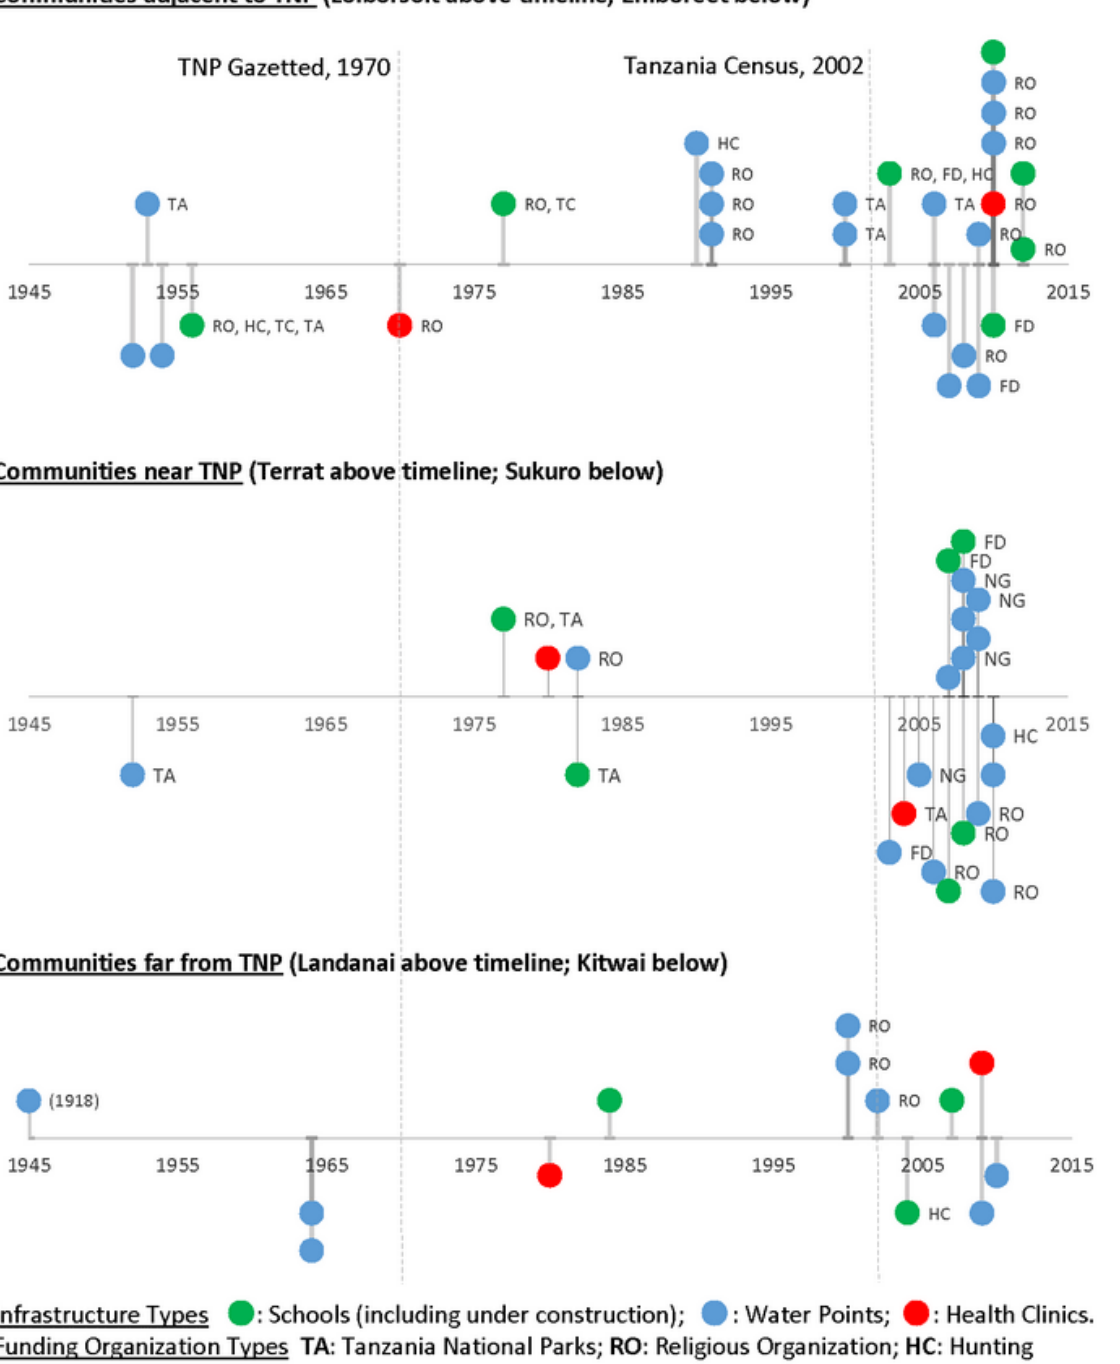
Fig. 2 . Study community timelines of infrastructural features and corresponding funding organization types, 1945-2010. TNP is Tarangire National